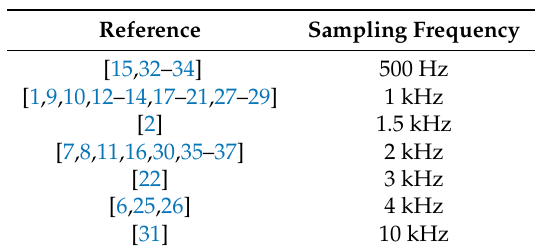
Table 2. Reported sampling frequency.